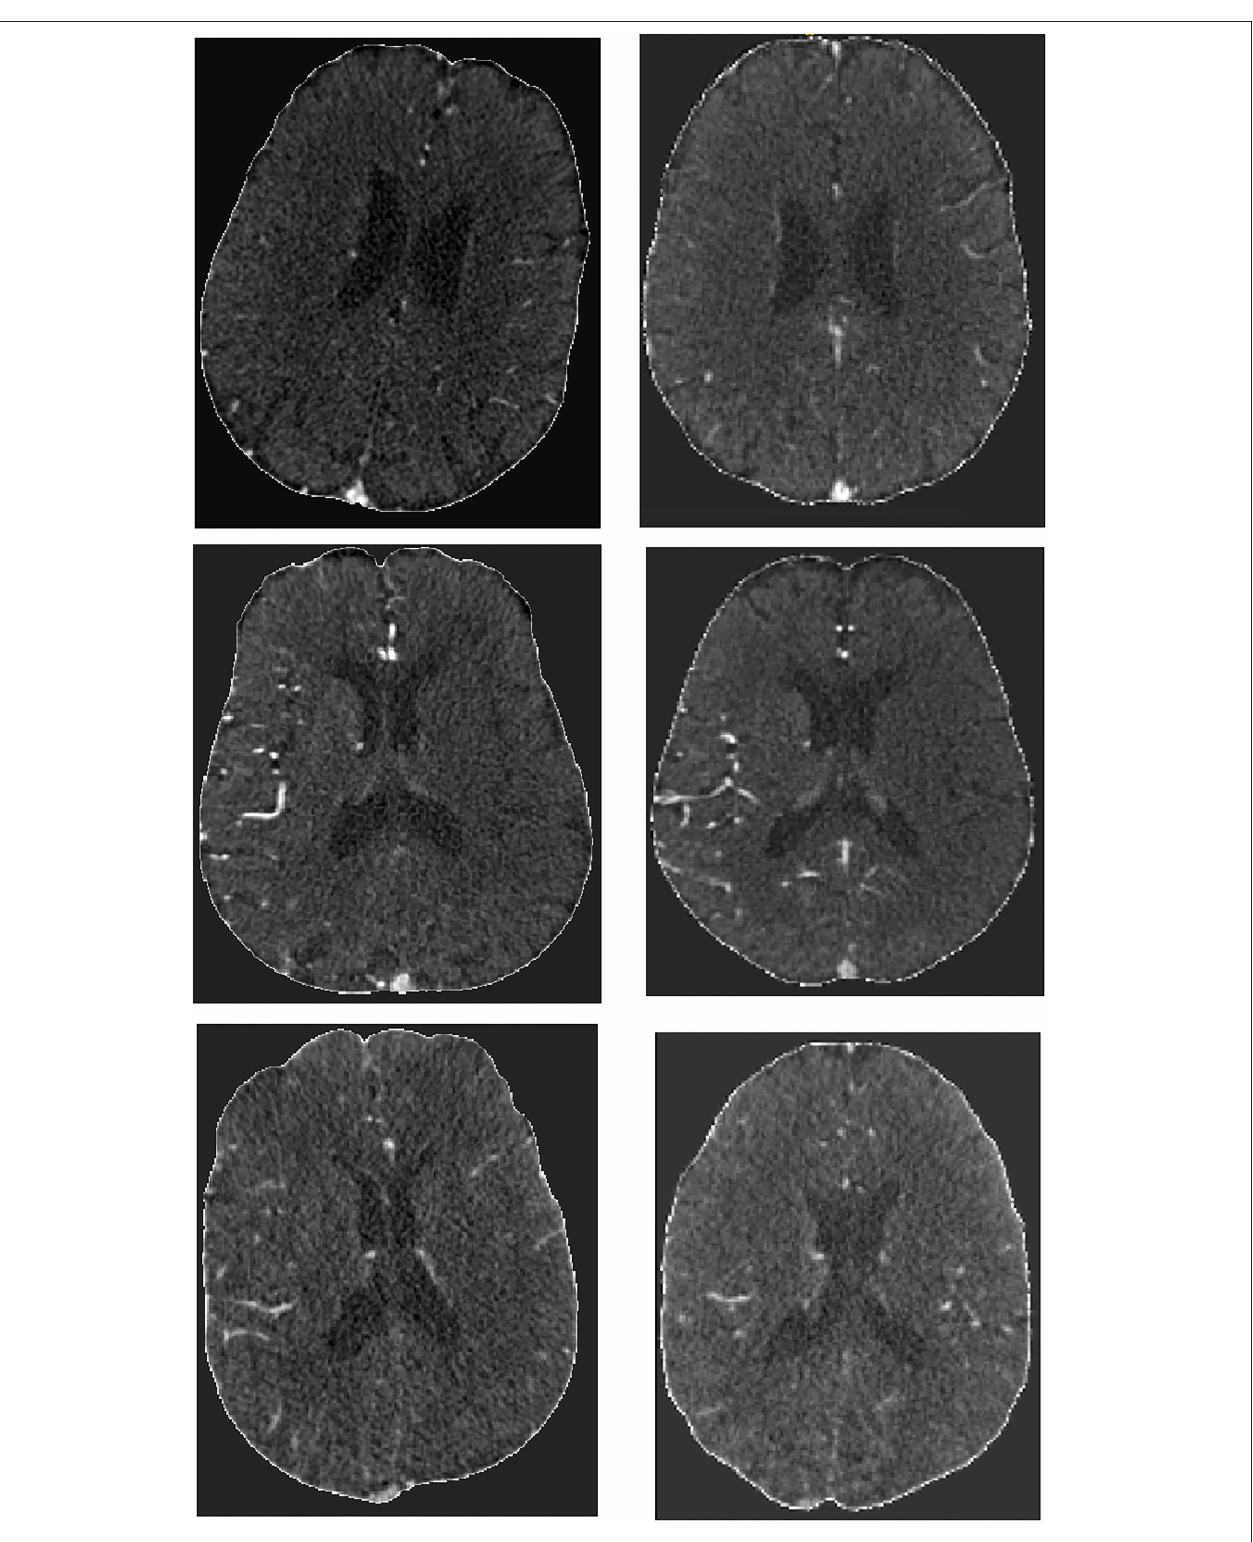
FIGURE 2 | Example of skull stripped scans (Left) and post-registration results (Right).